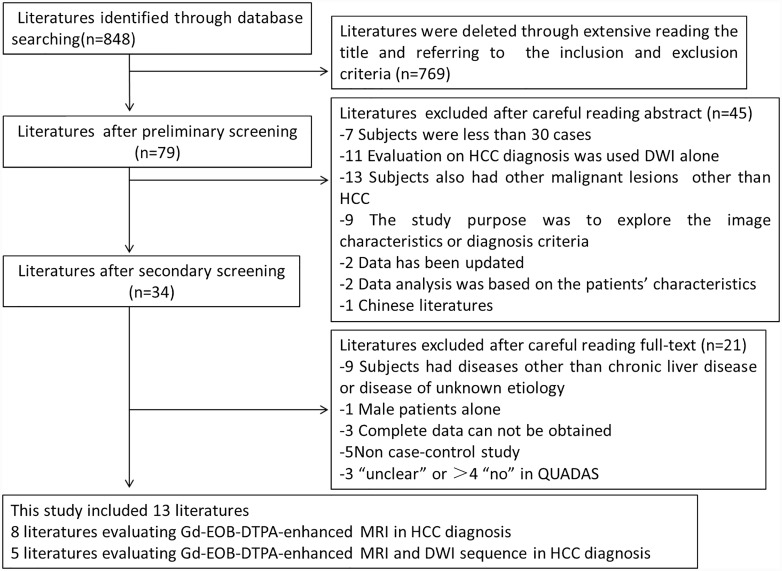
Flow diagram of study selection.